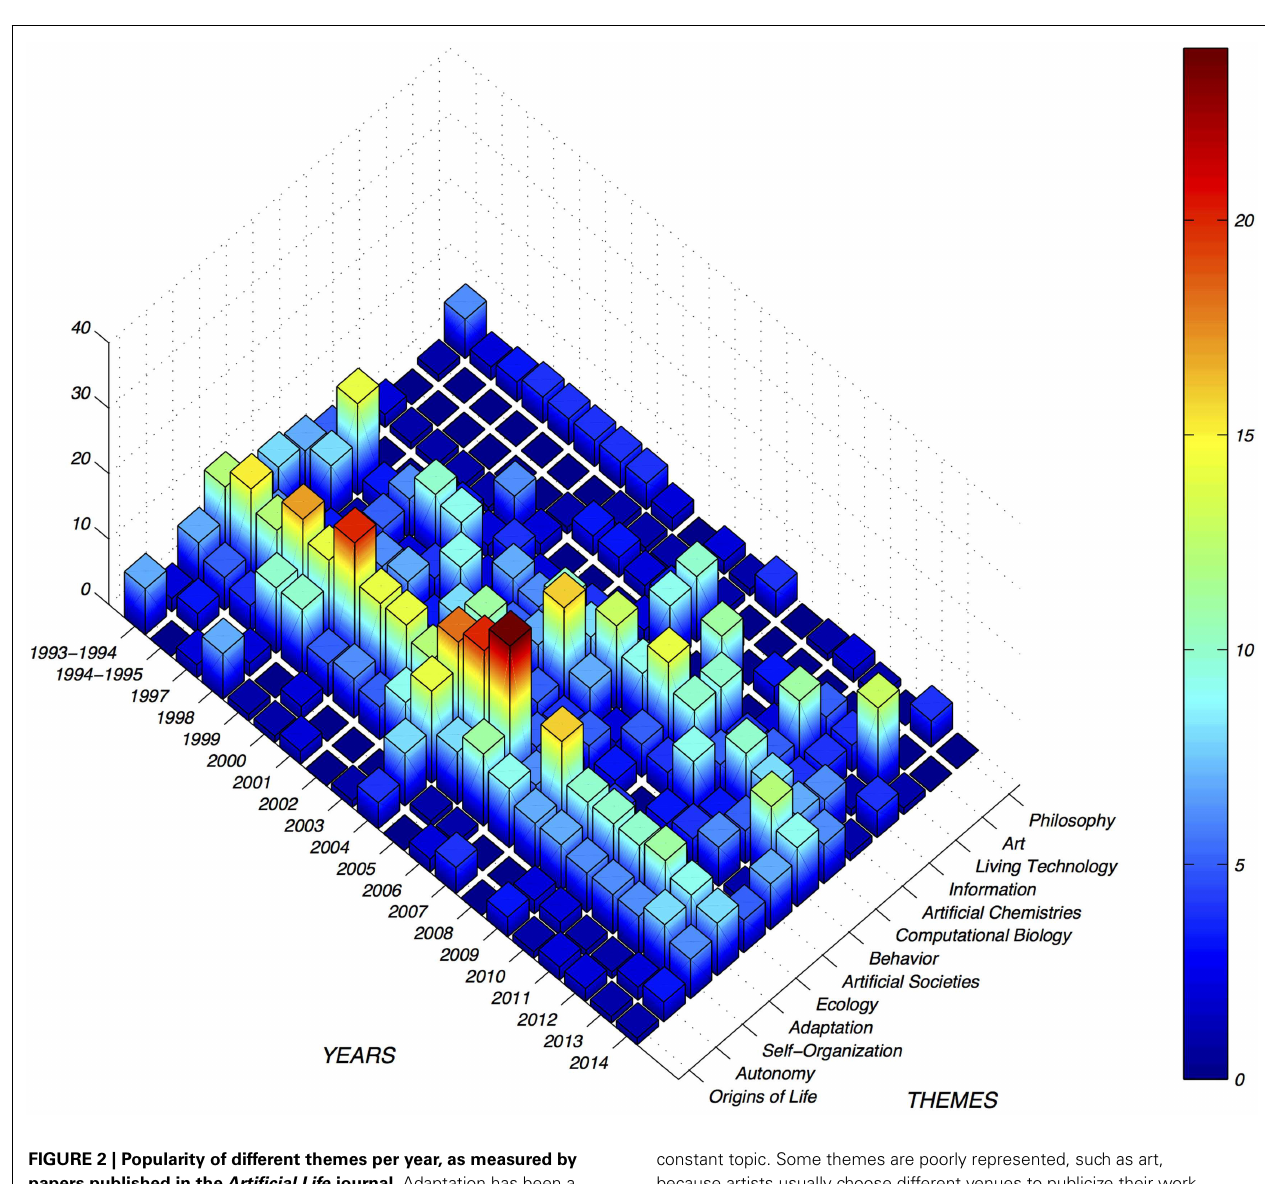
FIGURE 2 | Popularity of different themes per year, as measured by papers published in the Artificial Life journal . Adaptation has been a dominant theme in the journal, as it includes evolution, development, and learning. Self-organization has not been that popular, but is a